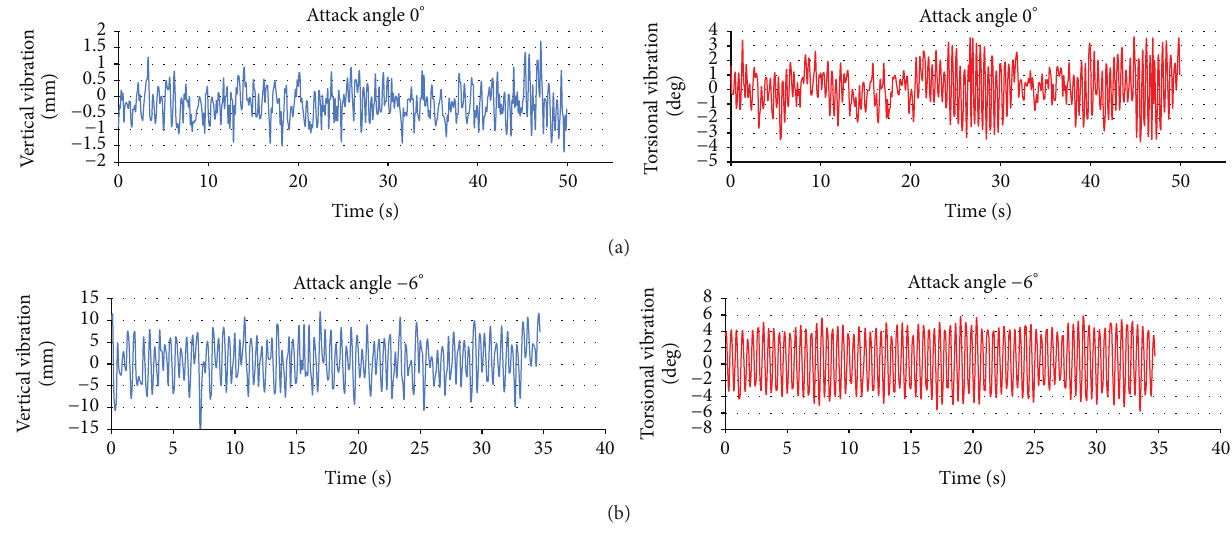
Figure 4: Vertical and torsional vibrations for (a) 0 ∘ at 13.0 m/s ( 𝑈/𝑓𝐵 = 10.13) and (b) − 6 ∘ at 9.0 m/s ( 𝑈/𝑓𝐵 = 7.01).